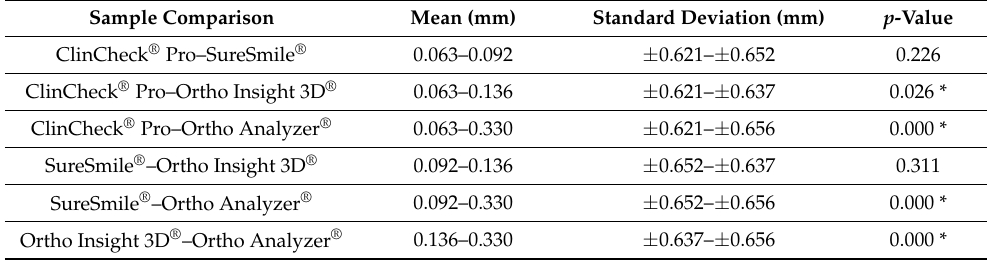
Table 2. Pairwise comparison for extrusion/intrusion.